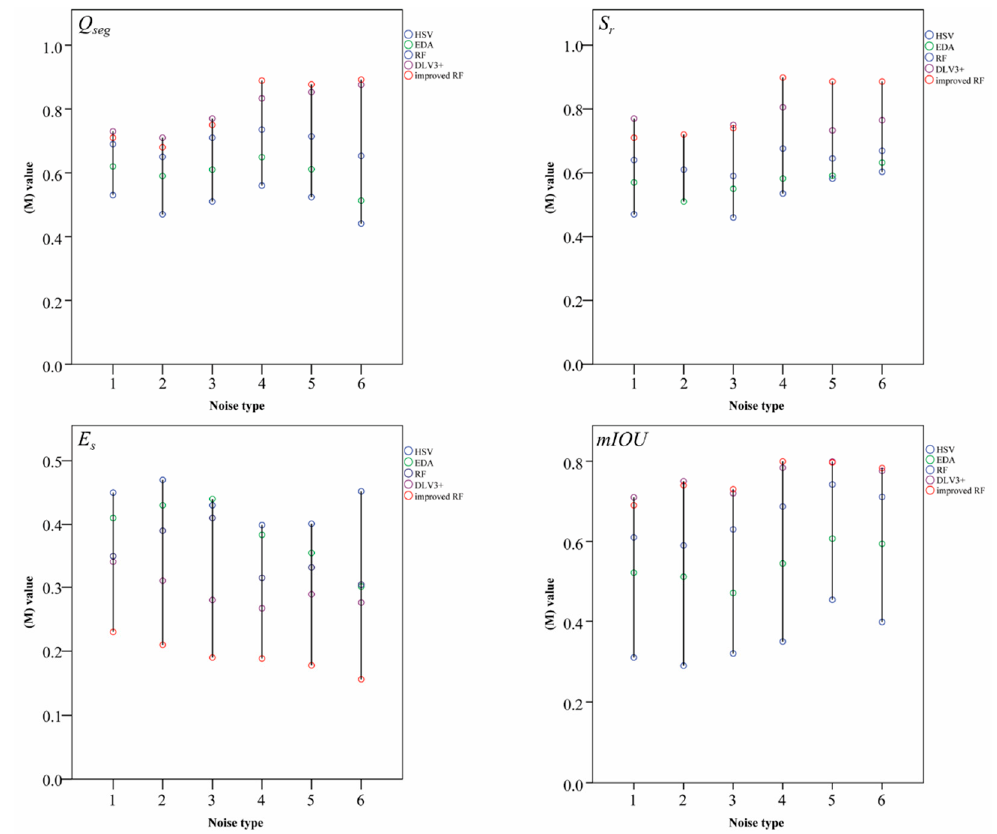
Figure 7. Results of image-segmentation methods for input data with different noise added. The color points in each box represent how the indices vary as different types of noise are added. Panels 1–6 show the results for the different types of noise: (1) Gaussian, (2) Poisson, (3) salt and pepper, (4) Gaussian noise removed by a median filter, (5) Poisson noise removed by a median filter, (6) salt and pepper noise removed by a median filter.